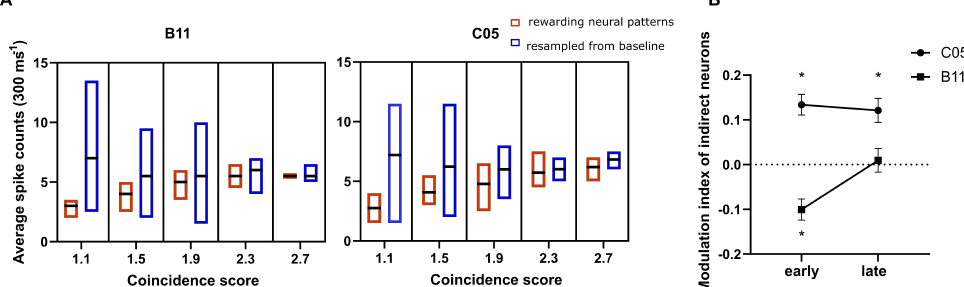
Figure 6. Efficient firing in modulating NCS for the BMI task. ( A ) The spike counts (averaged over trigger unit and target unit) of the rewarding neural patterns from the task block were significantly lower than those of the sampled neural patterns from the baseline block (Mack–Skilling test, B11: p < 1 × 10 − 4 ; C05: p < 1 × 10 − 4 ). The spike counts were grouped into five blocks according to the coincidence scores of the corresponding neural patterns. The black line represents the median. ( B ) Average modulation index after pooling over all significantly modulated indirect neurons across sessions (mean ± SEM). The asterisks above the lines indicate a significant positive departure from zero, whereas those below represent values smaller than zero. * p <